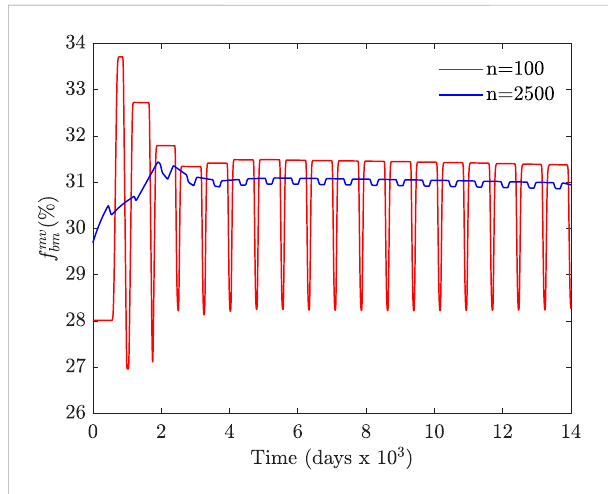
FIGURE 6 Temporal evolution of f mv bm (%) for two different time windows of the moving average. This evolution corresponds to the compression load case with an initial random distribution of f bm ∈ [27, 29]%.